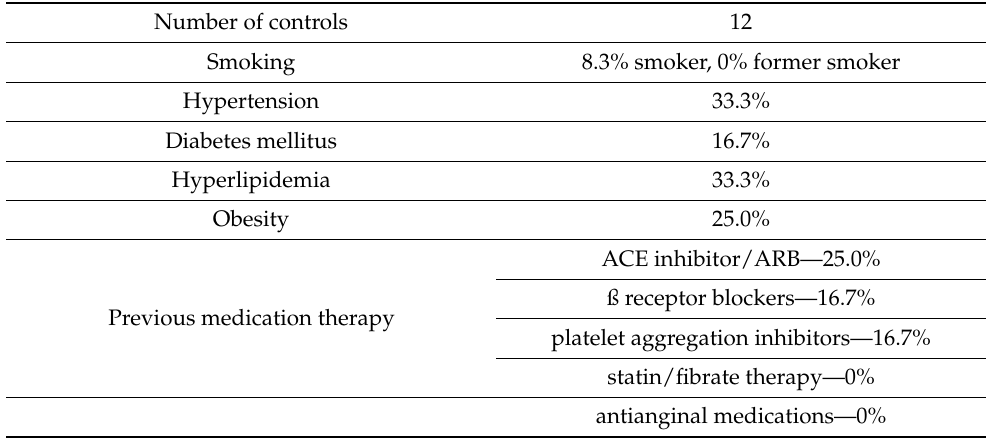
Table 2. Main demographic and clinical characteristics of the